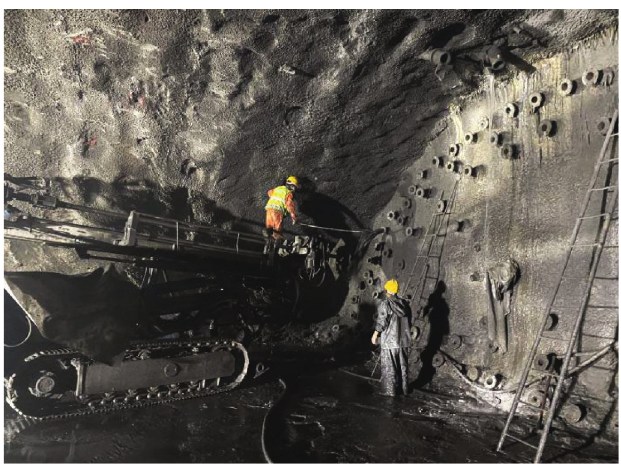
Figure 13: Use sulfoaluminate cement for grouting hole